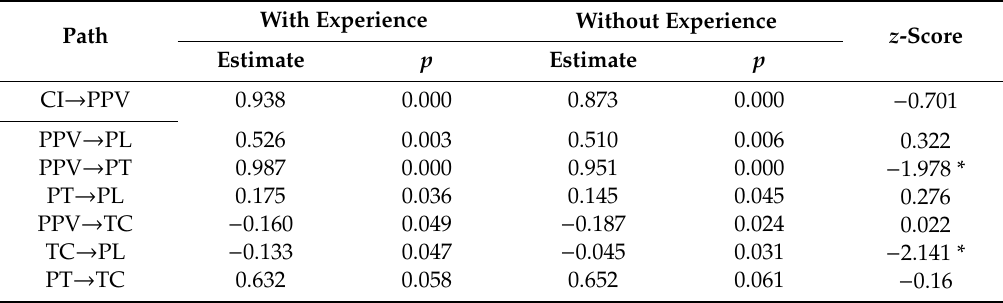
Table 9. Path coe ffi cients between groups with and without user